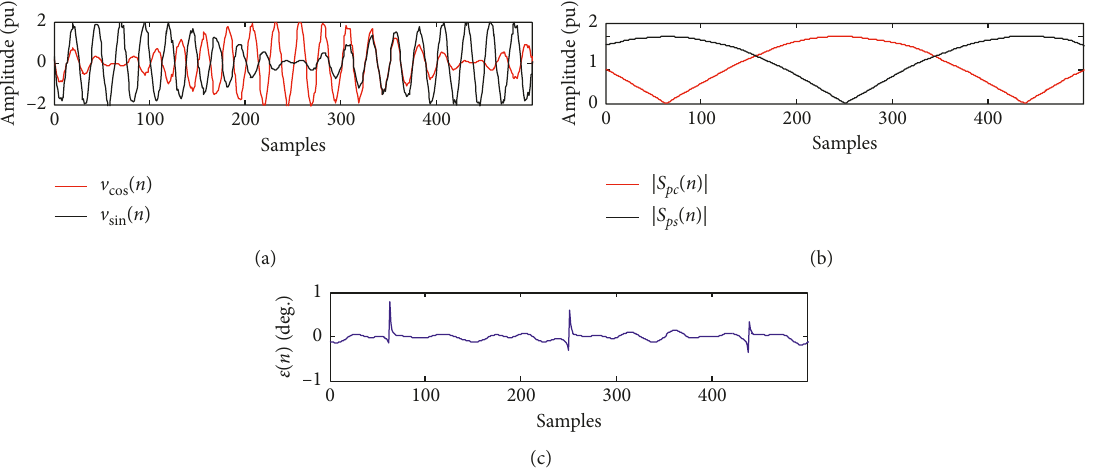
n under various conditions. ( )